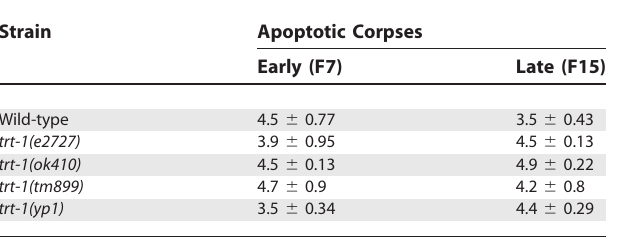
Table 1. Basal Germline Apoptosis Is Normal in trt-1 Mutants at Early (F7) and Late (F15)